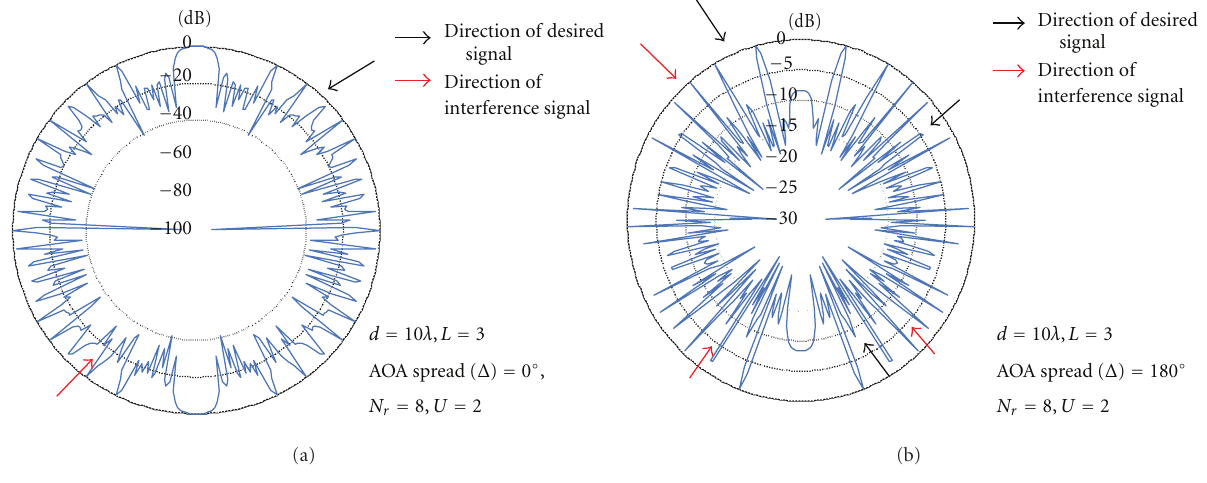
Figure 13: FDAAA radiation pattern when antenna separation d = 10 λ